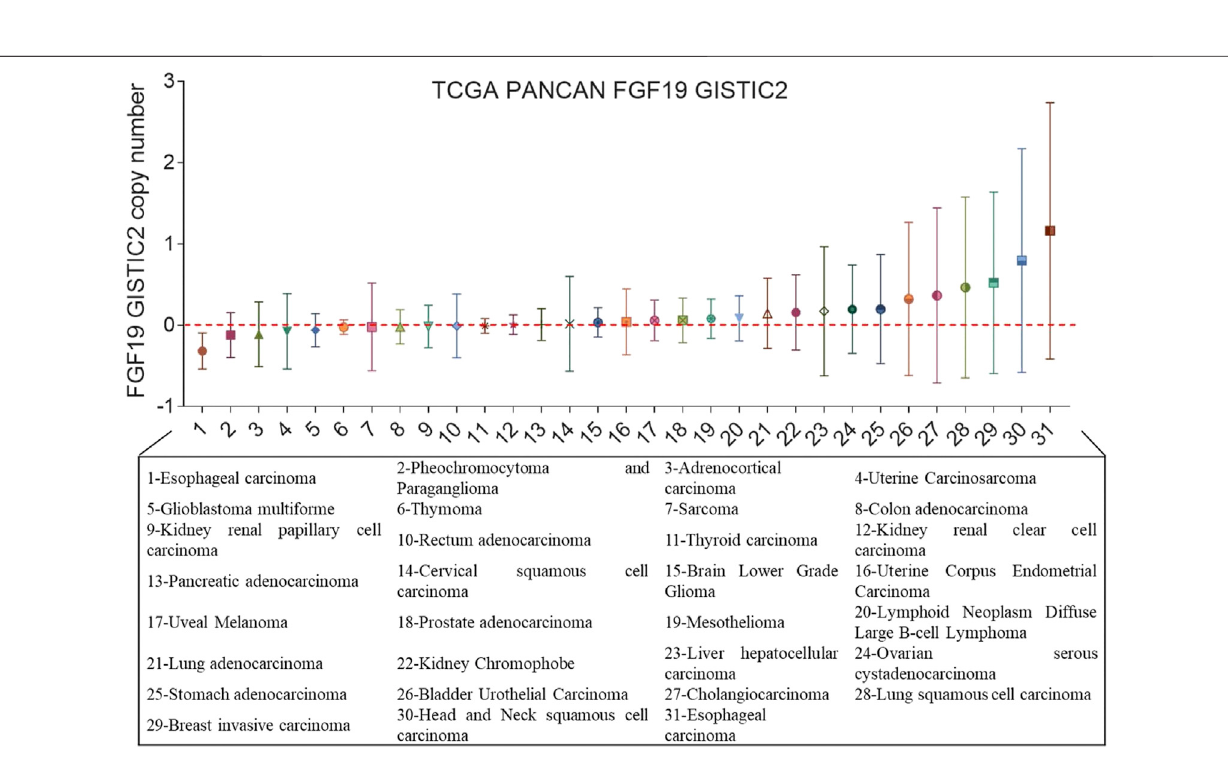
Frontiers in Pharmacology |